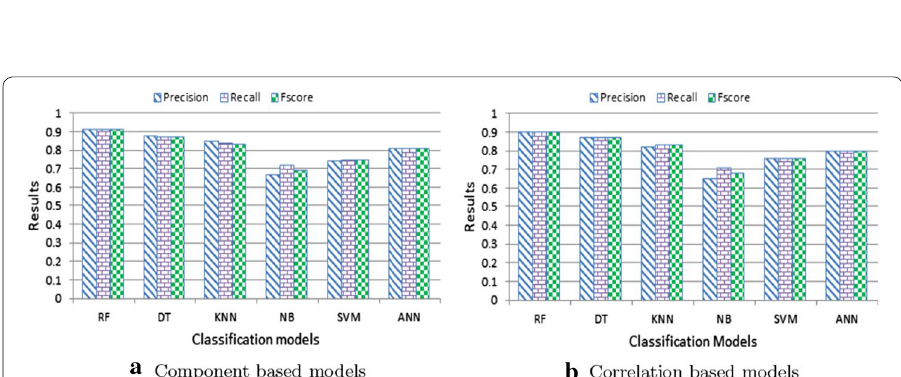
Fig. 9 Effectiveness comparison for various machine learning classification models considering both the component based and correlation based context-aware